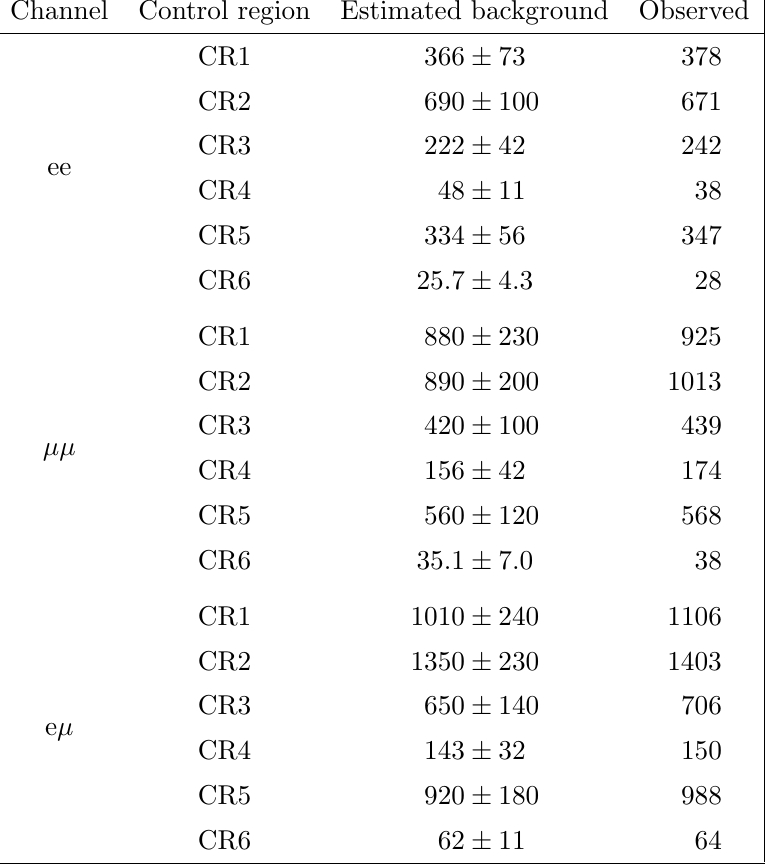
Table 2 . Observed event yields and estimated background in the control regions. The uncertainties in the background yields are the sums in quadrature of the statistical and systematic